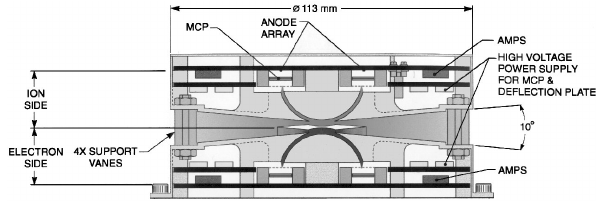
Fig. 4. Cross section through the MEDUSA sensor. The electron- and ion sides are identical apart from the high voltage polarities and the inclusion of high voltage capacitors between the anodes and amplifiers on the electron side.